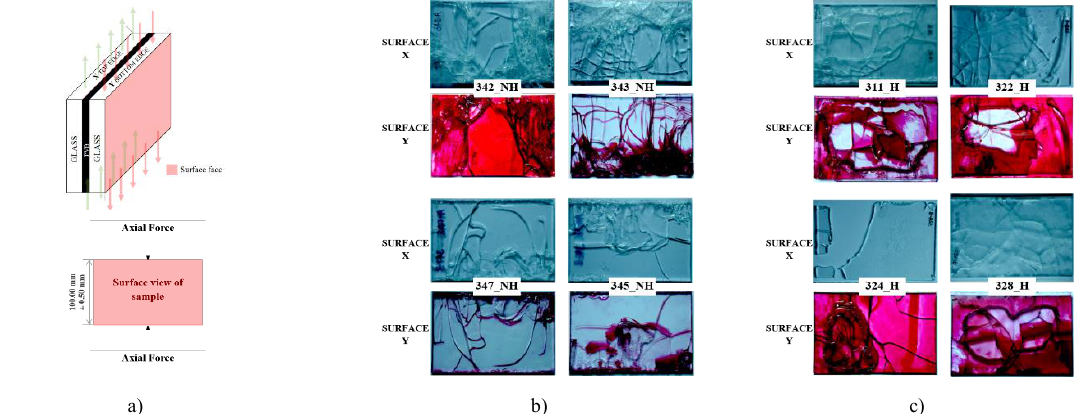
Fig. 12 Surface view of substrate X and Y for humidity-aged laminated glass samples post-test a) Orientation of sample in jig b) Surface view of selection of samples post-test that highlights the different density of glass fragments at different loads c) Surface view of a selection of samples post-test that highlights how the glass fracture patterns correspond with delamination.